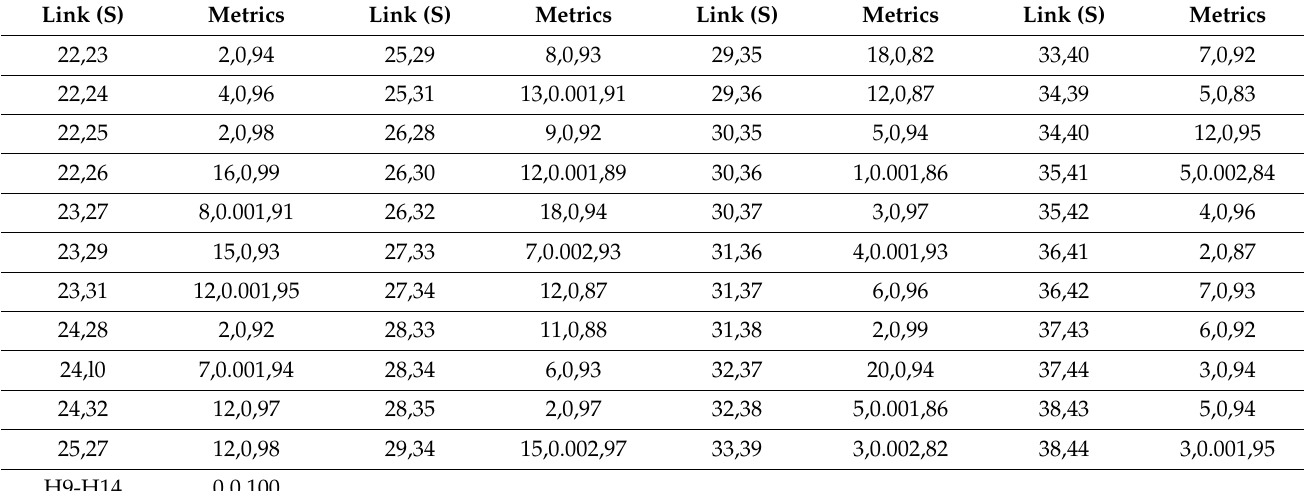
Table A2. Controller B link metrics in the simulation model. Metrics: delay (ms), packet loss (%), and bandwidth